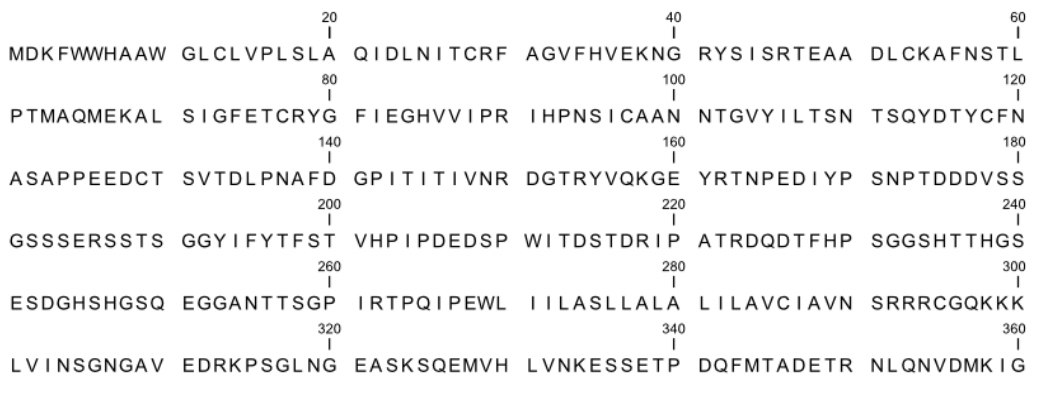
Table 1. CD44 sequence and (glyco)peptides derived from the stem